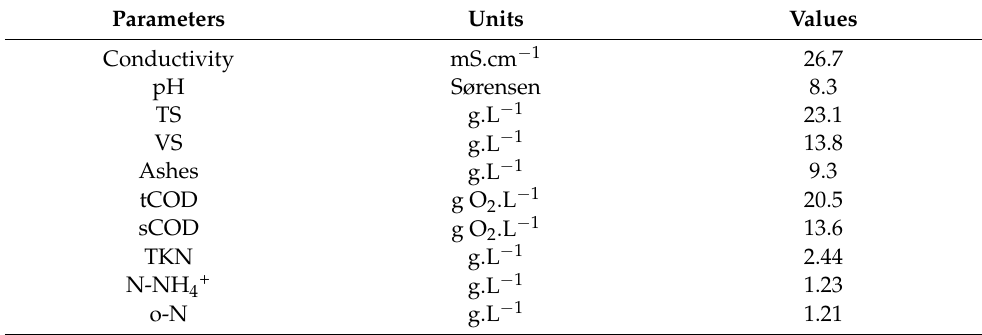
Table 2. Chemical characterization of the inoculum.